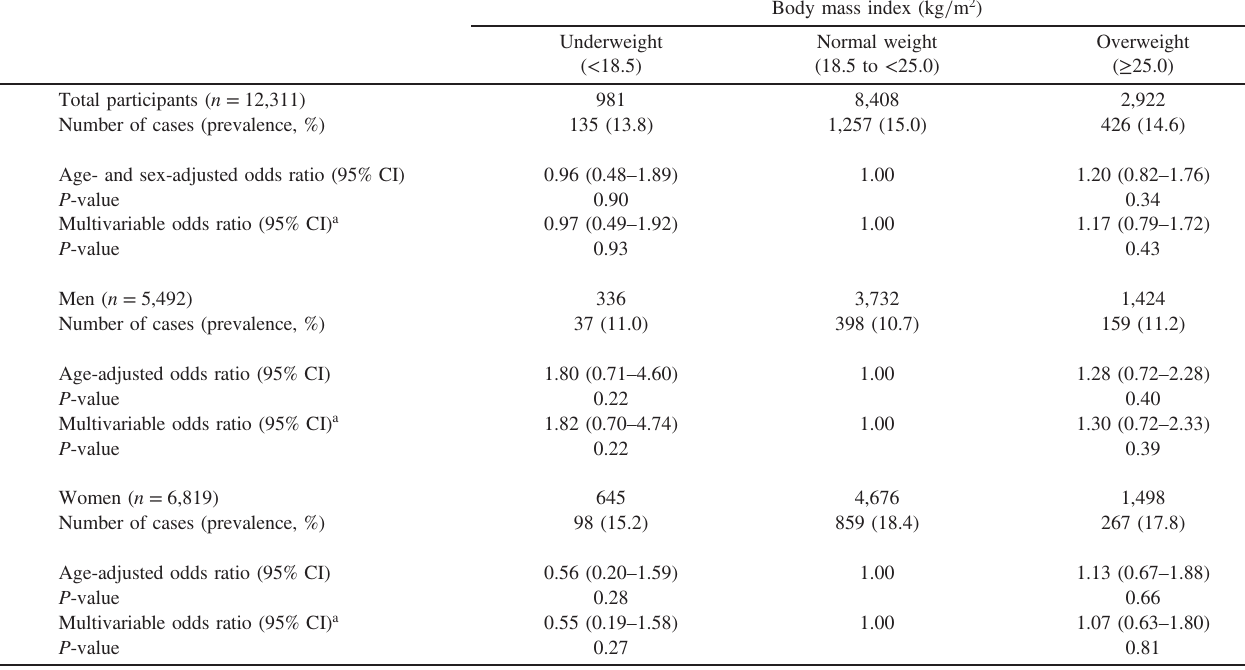
Table 2. Odds ratios of past history of herpes zoster by body mass index category in all participants, men and women